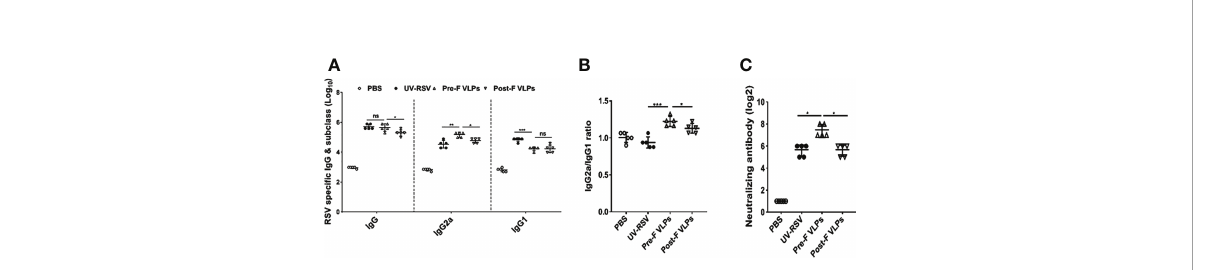
FIGURE 3 VLPs elicited humoral immune responses in mice. Groups of fi ve BALB/c mice were inoculated with 10 m g of Pre-F VLPs, Post-F VLPs, 1×10 5 PFU of puri fi ed UV-inactivated RSV or 100 m l PBS following i.m. inoculation. Mice in all groups received a booster twice in 2-week intervals with the same amount of inoculum. Sera were collected at 2 weeks after the fi nal immunization to determine RSV-speci fi c IgG, IgG2a, and IgG1 titres via ELISA (A, B) and neutralization antibody (NAb) titres via the neutralization assay (C) . Data are expressed as the GMT (geometric mean titre) of fi ve mice. P values were calculated with one-way ANOVA or Student ’ s t test followed by the Tukey test. *** P < 0.001; ** P < 0.01; * P < 0.05; ns, not signi fi